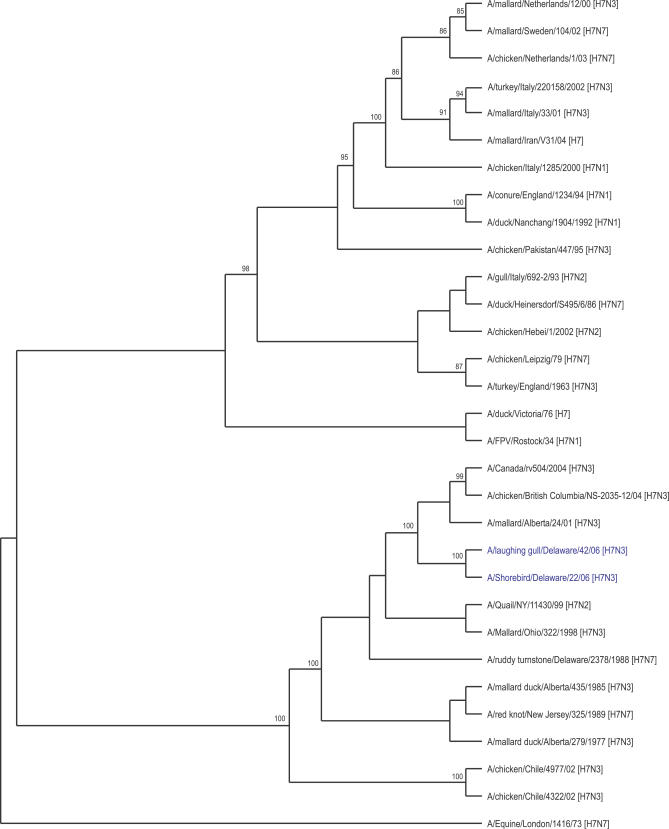
Phylogenetic Tree for the HA-1 Gene (Nucleotides 76–1026) of H7 Influenza A VirusesThe nucleotide sequences were analyzed by PHYLIP software, version 3.66 [41], using the neighbor-joining method with 100 bootstraps. The tree was rooted with the A/Equine/London/1416/73 HA sequence.